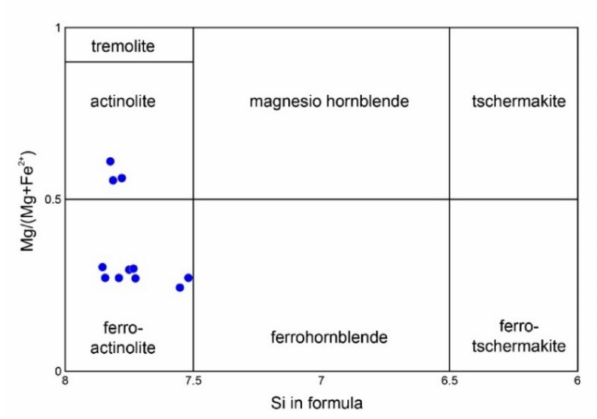
Figure 8. Classification of the calcic amphibole diagram after [19].